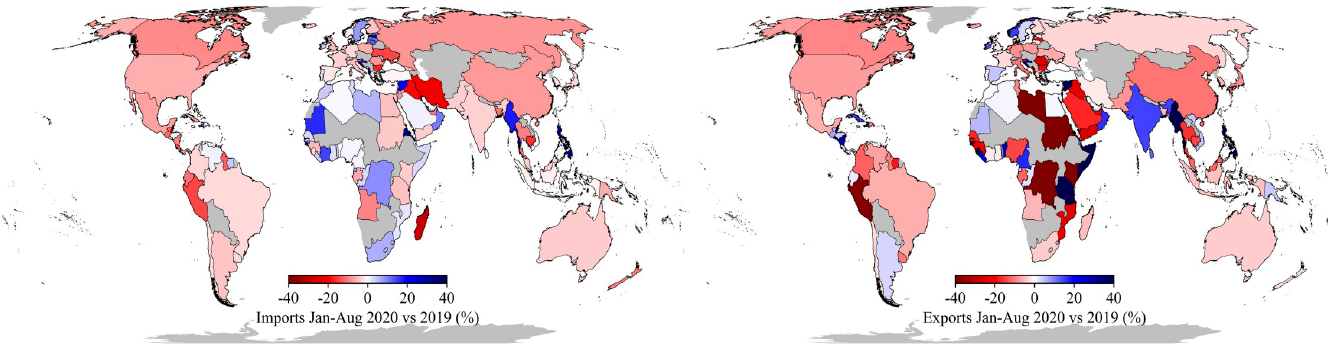
Fig 2. Country-level relative trade losses. The relative trade losses for Jan-Aug 2020 compared to 2019 expressed in percentage change. Grey countries indicate no data available. This figure was generated using the ‘Geopandas’ package (https://geopandas.org) and Python Programming Language (version 3.7). The underlying basemap is derived from ‘Natural Earth’ global vector data (https://www.naturalearthdata.com).